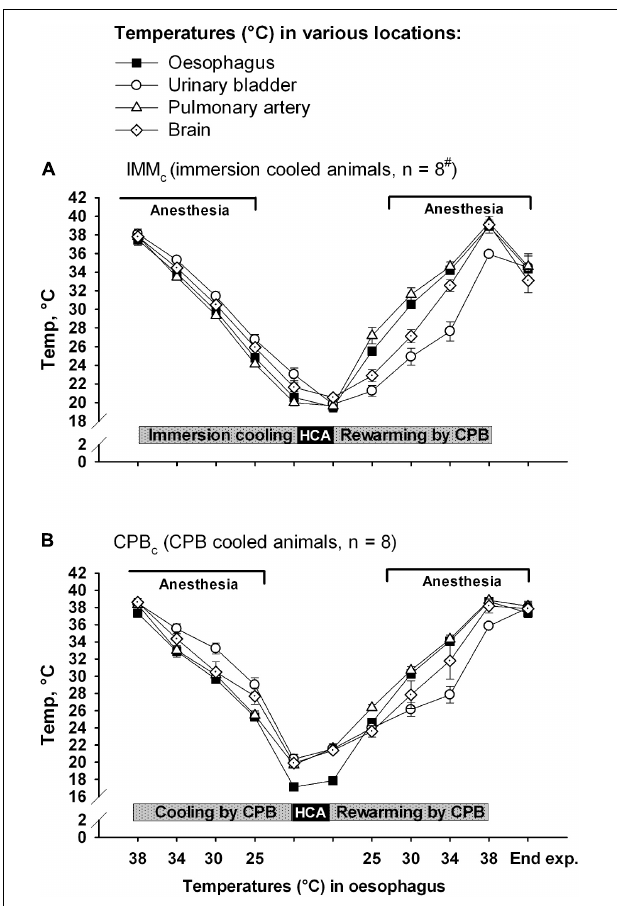
FIGURE 1 | Temperatures at various body locations. (A) Immersion cooled animals (IMM c group), and (B) in animals cooled by CPB (CPB c group). Data presented as mean and SEM. # n was reduced to 4 animals at the end of experiments (End exp.) in IMM c group.